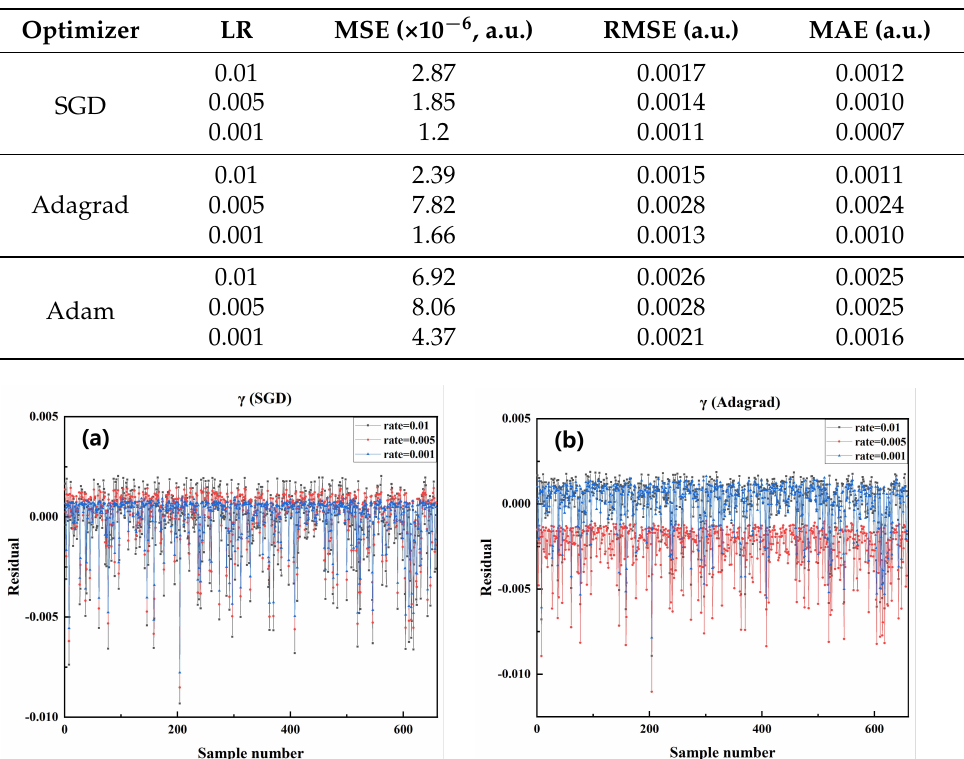
Table 4. Performance evaluation results for predictions of γ on test datasets with models trained with different optimizers and different LRs.